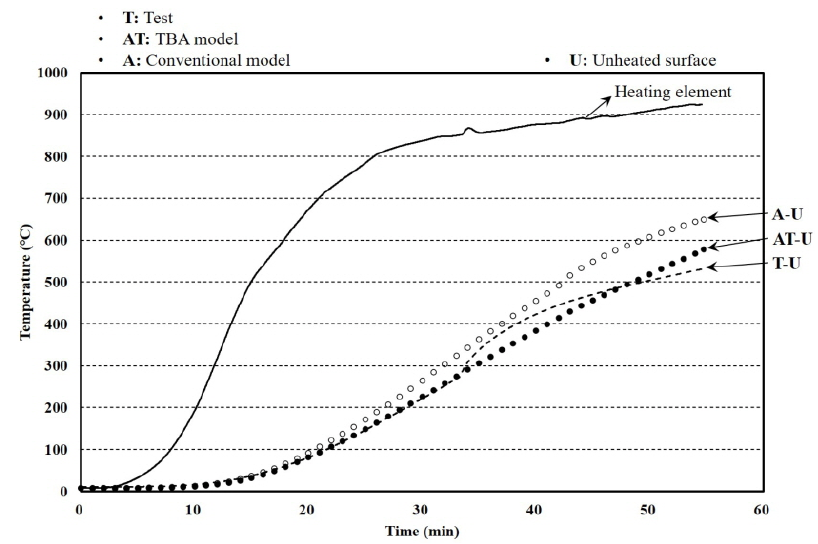
Figure 9. Temperature results of insulated furnace tests and FEA.